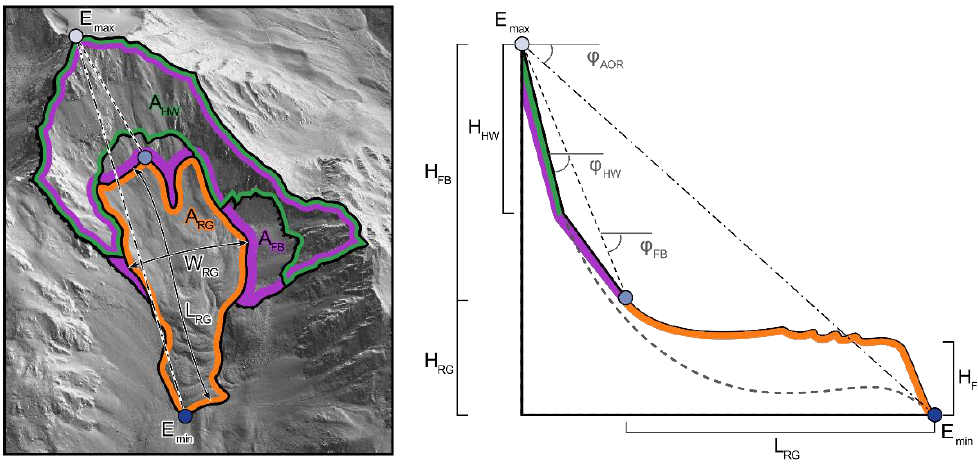
Figure 2. Overview of geometric candidate parameters used for analysis. See Table 2 for abbreviations.